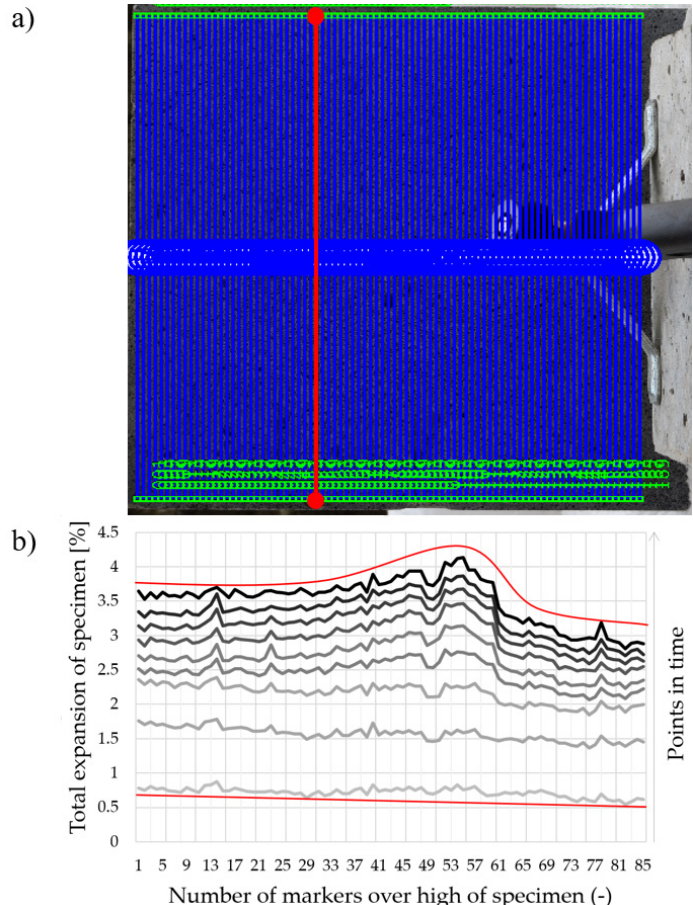
Figure 18. Measurement of the total expansion of the specimen: ( a ) two markers linked together to measure the distance between them, and ( b ) results of the analysis of the total expansion of the specimen along its height and over time.